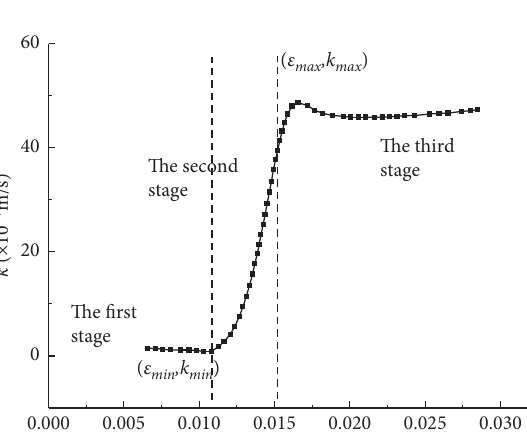
Figure 3: Yield curve.